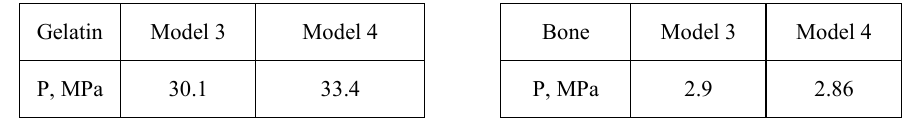
Table 3. The results for the three-dimensional